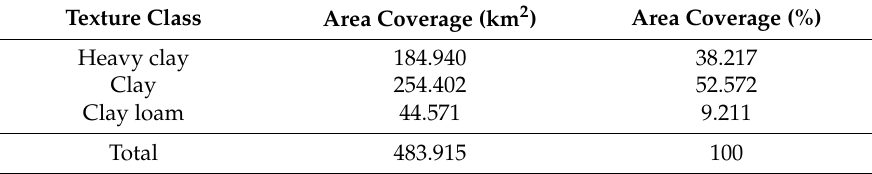
Table 4. Area coverage of soil texture classes for the Jema watershed.